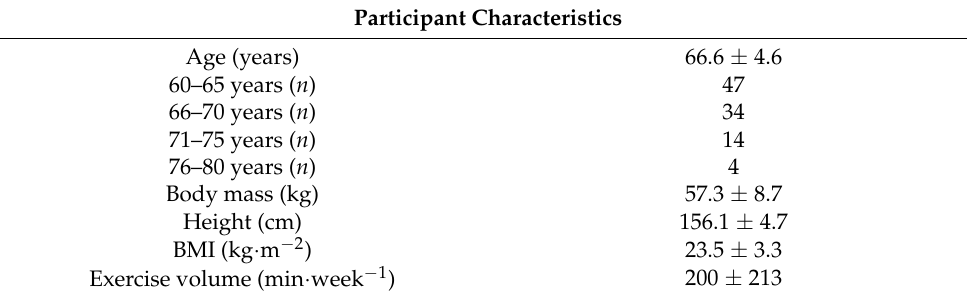
Table 1. Participant characteristics ( n =